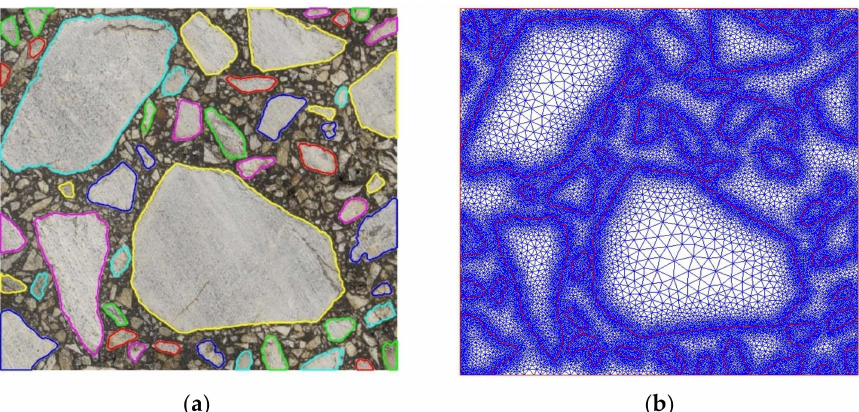
Figure 6. Boundaries of the captured inclusions overlaid on the original image ( a ) and the corre- sponding fine mesh ( b ).